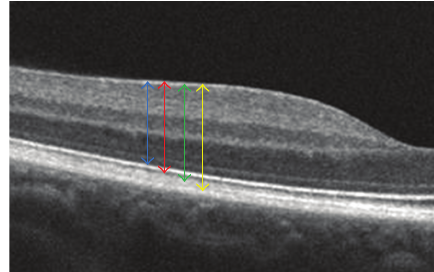
Figure 3: Example of high-definition cross-sectional image from a healthy volunteer allowing us to locate easily anterior and posterior retinal boundaries placement by Stratus, Topcon, Cirrus, and Spectralis. Blue arrow delimiting OCT retinal boundaries as inner limiting membrane (ILM) and IS/OS interface (Stratus), red arrow as ILM and OS/pigment epithelium junction (Topcon), green arrow as ILM and Verhoe ff ’s membrane corresponding to the interdigitations of the external article layers of the photoreceptors in the pigment epithelium (Cirrus) and yellow arrow as ILM and Bruch’s membrane